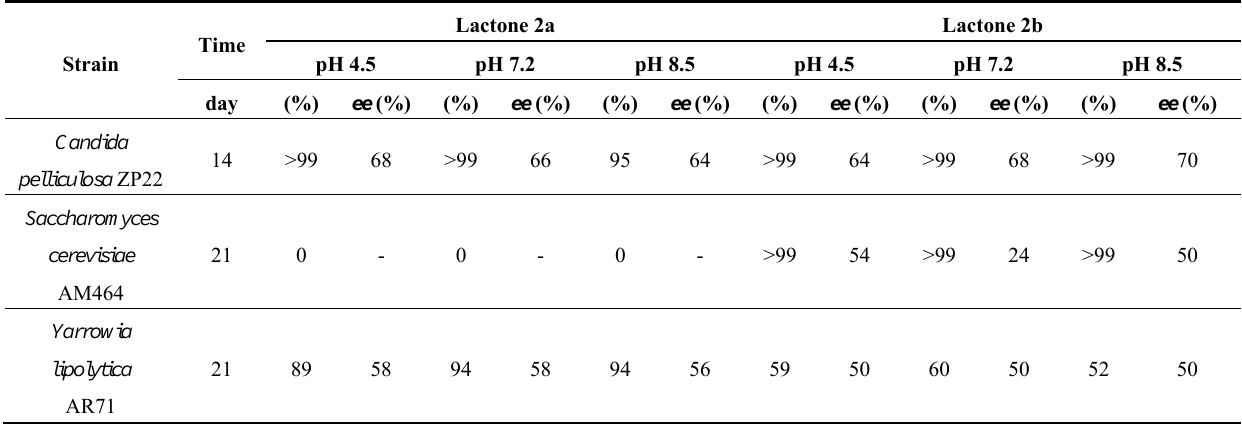
Table 3. The conversion (according to chiral gas chromatography, CGC) of diols 3a – b